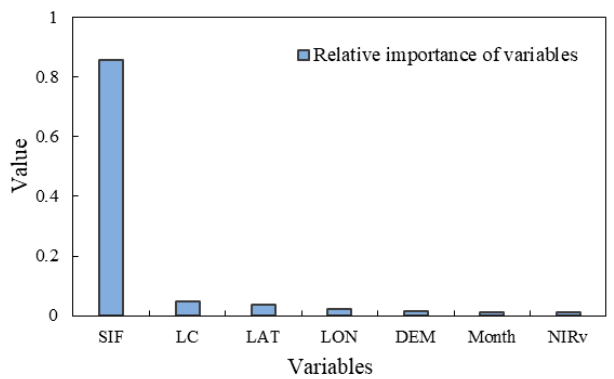
Figure 7. The relative importance of variables to the GPP estimation GBRT model built from the training dataset.